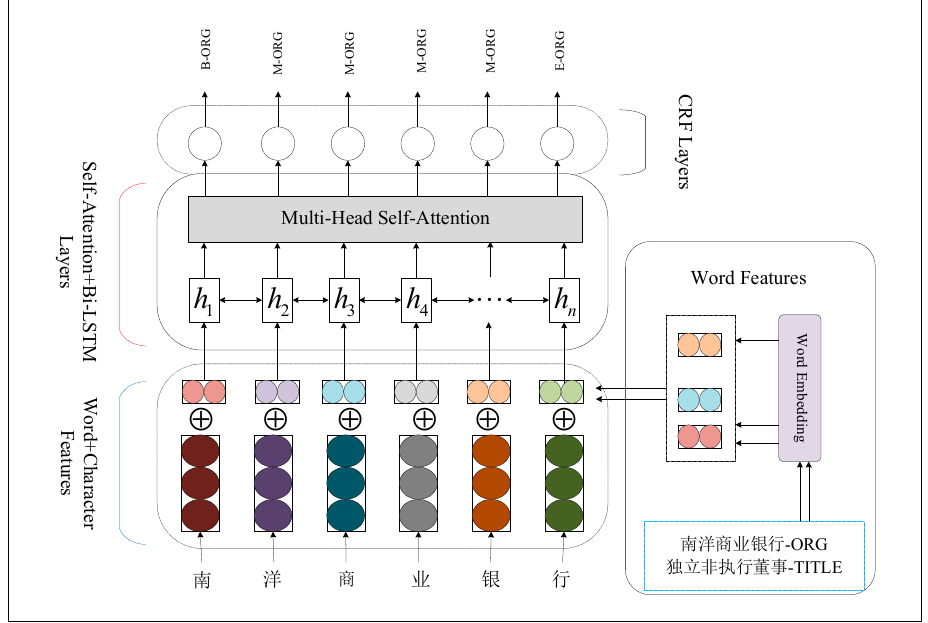
Figure 3. Network structure.